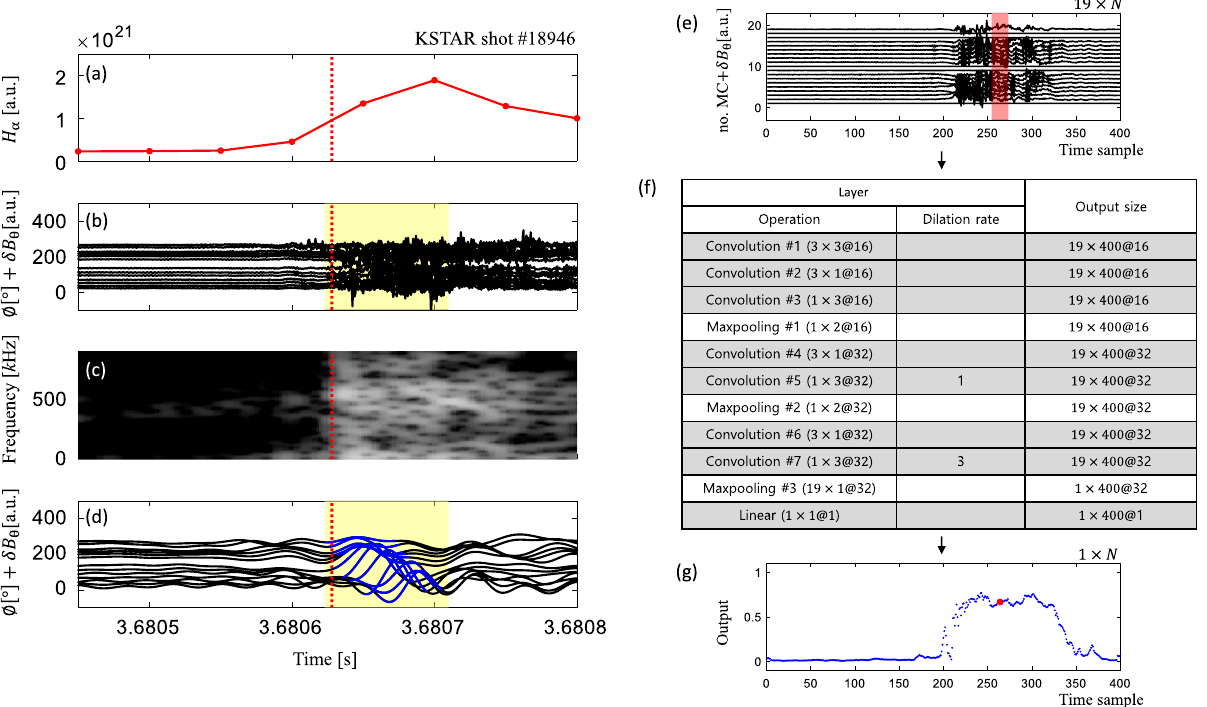
Figure 1. An example of solitary perturbation (KSTAR shot #18946) and network architecture for the SP identification model. ( a ) H α signal, ( b ) 19 raw toroidal MC signals, ( c ) spectrogram of the time-series data for the 11th toroidal MC, and ( d ) band-pass filtered MC signals (5–30 kHz) of the example. SP is highlighted in blue color. Red vertical dotted line and yellow box in ( a )–( d ) respectively indicate the start time of the boundary burst and the duration of the SP (~ 90 μs). ( e ) network input: 19 toroidal MC signals with 1 MHz sampling frequency, ( f ) network architecture, and ( g ) network output: SP probability corresponding to each temporal frame. One output frame, indicated by a red dot in ( g ), is affected by the input region of 19 coils and 19 time samples (corresponding to 19 μs) highlighted in the red box in ( e